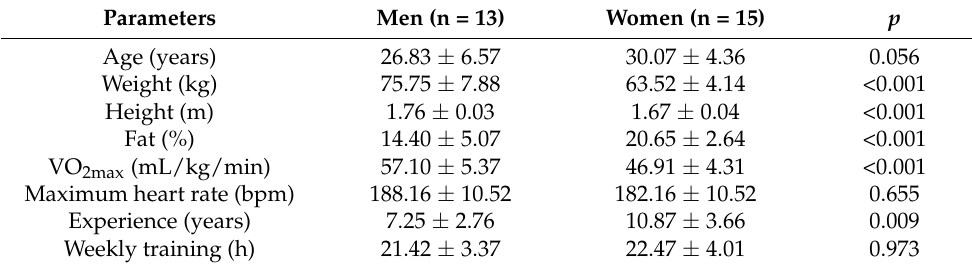
Table 1. Participants’